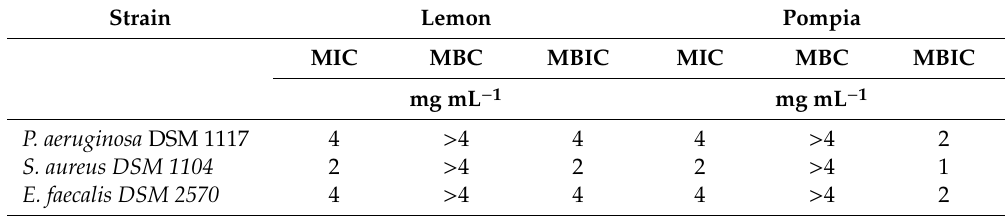
Table 4. MIC, MBC, and MBIC values observed in selected Gram-positive and Gram-negative bacteria. Strain Lemon Pompia MIC MBC MBIC MIC